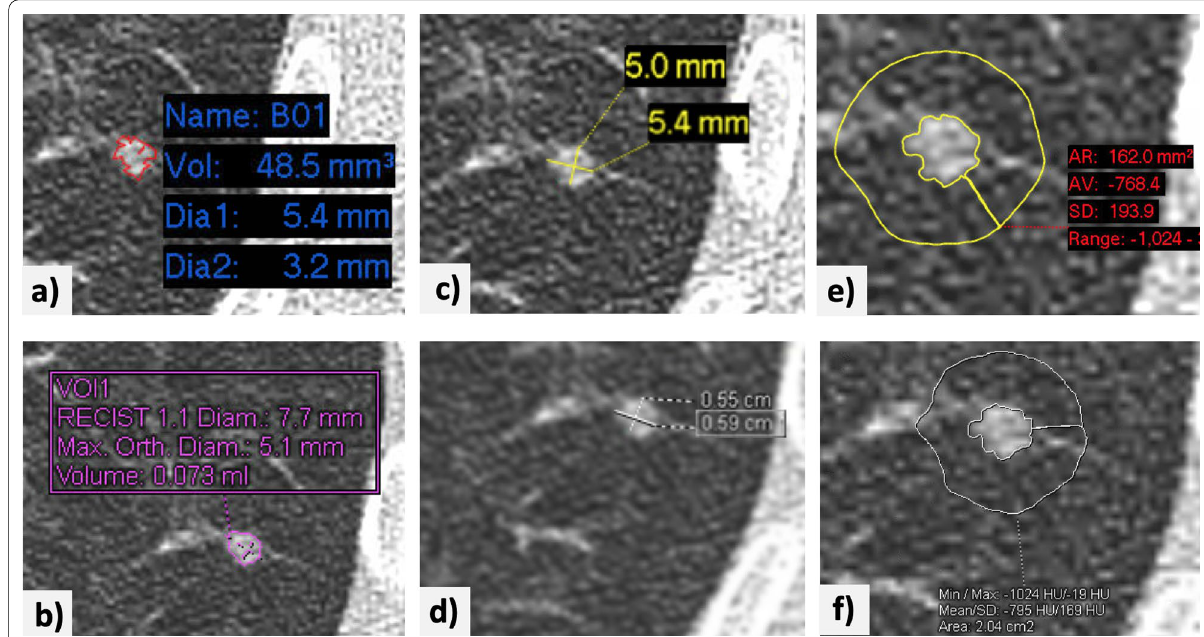
Fig. 1 Example of the implementation of the nodule measurement protocol. A small nodule is identified in the posterior segment of the left lower lobe of the lung. a , b The volumetric tools [Vue PACS, ver. 11.4.01.1011; Carestream © (tool 1) and Syngo via VB20, Siemens © (tool 2)] are used to segment the nodule, yielding volumes of 48.5 and 75 mm 3 , respectively. c , d The longest orthogonal diameters are measured manually using electronic calipers tools in both software packages. e , f A region of interest (5‑mm thickness) is drawn manually around the nodule for determination of the average attenuation of adjacent lung parenchyma ( 768.4 and 795 HU obtained with tools 1 and 2, respectively). The − − images have been edited to improve the readability of the